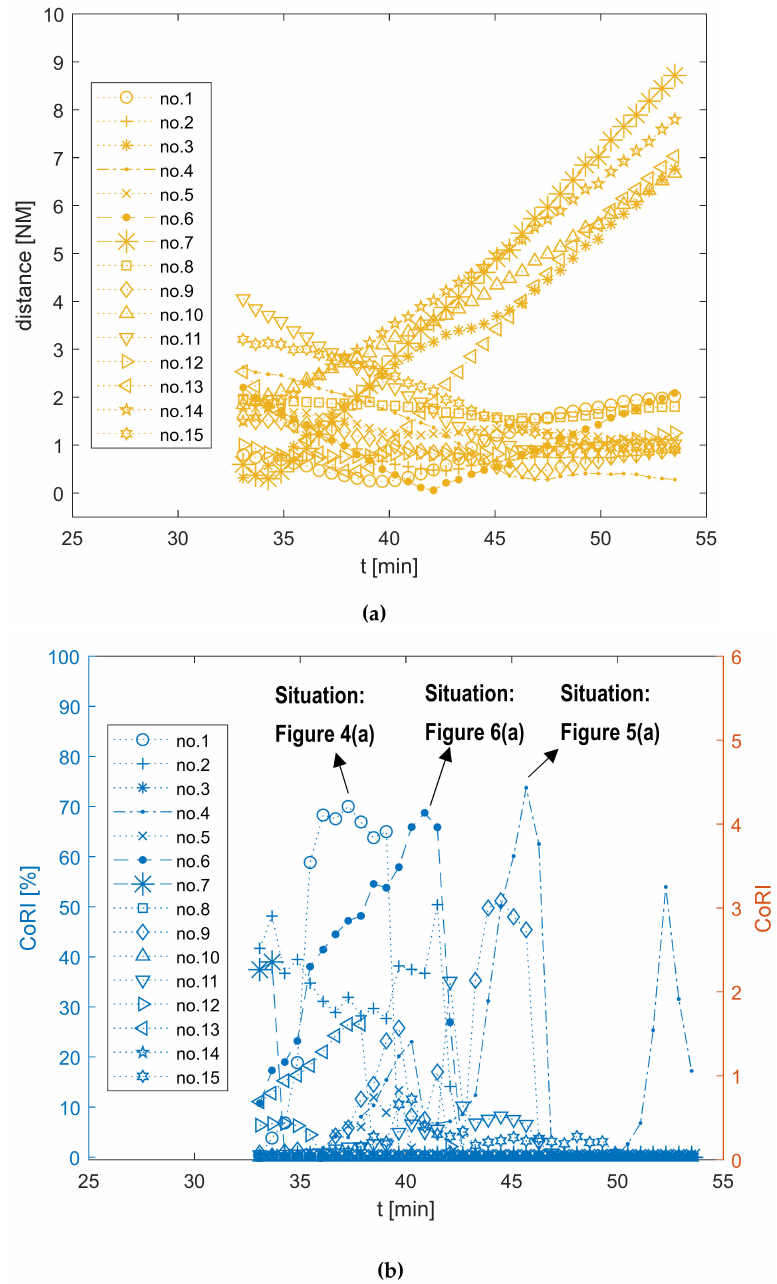
Figure 3. ( a ) Ship distance and ( b ) CoRI results by scenario no.: near-collision situation that occurred sequentially in scenario no.1—Figure 4a situation, no.6—Figure 6a situation, and no.4—Figure 5a